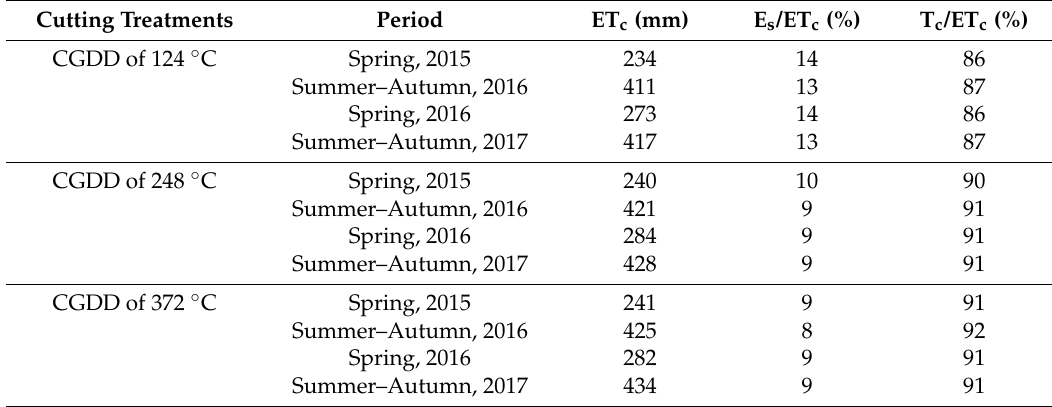
Table 10. Crop evapotranspiration (ET c , mm) and evaporation and transpiration ratios (E s /ET c and T c /ET c , %) for all cutting treatments and observation